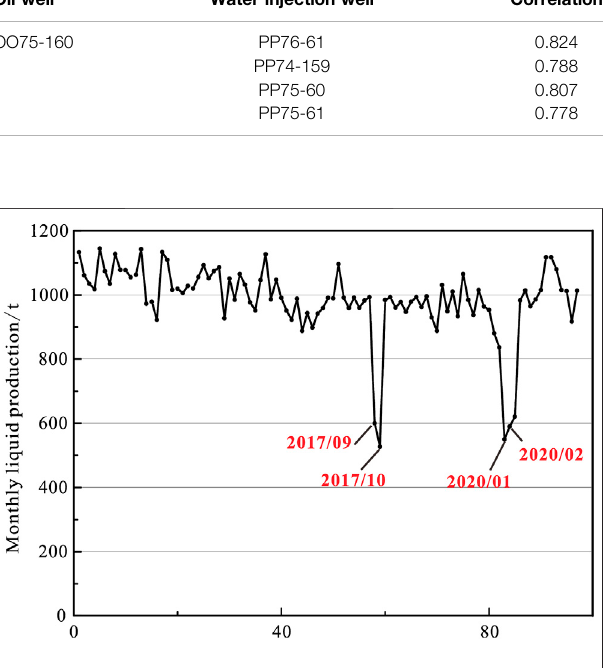
FIGURE 2 | Monthly fl uid production of oil well